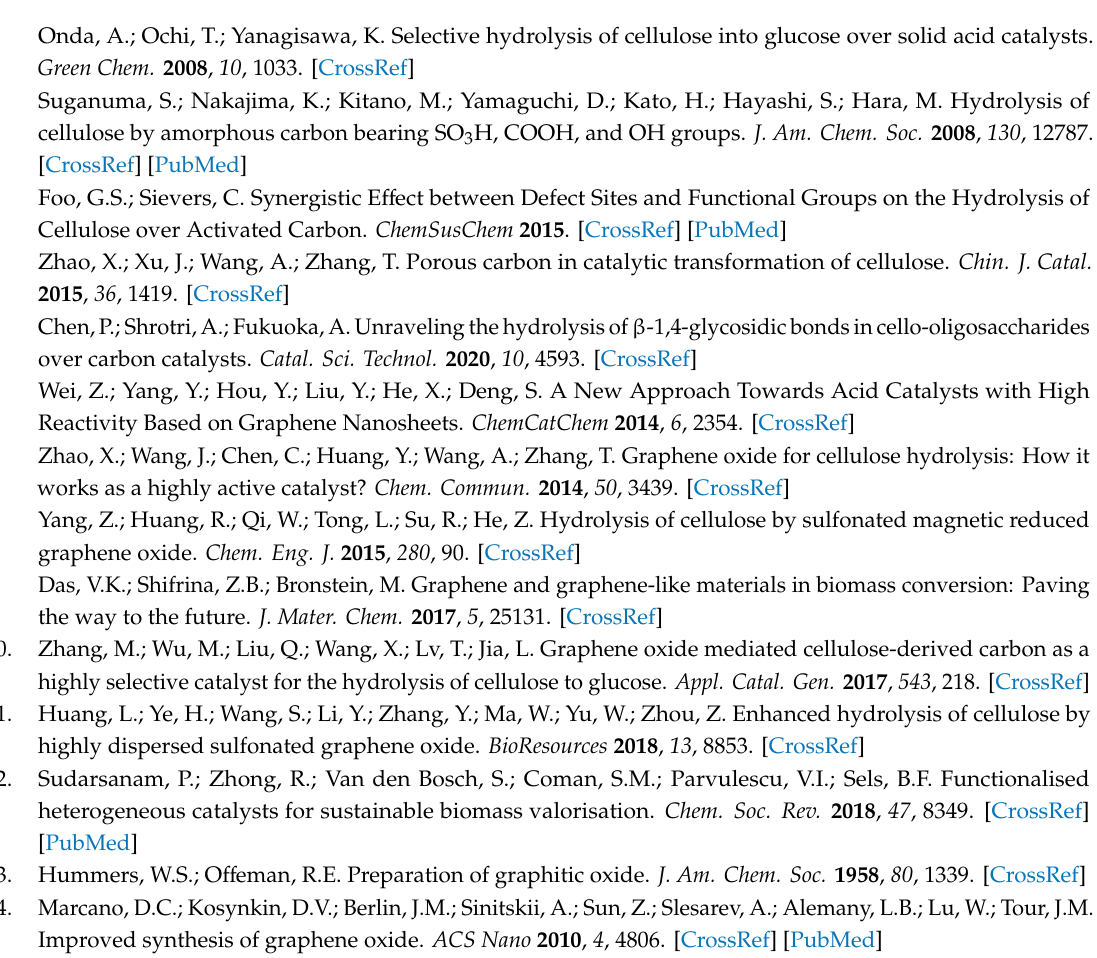
Figure S1: XRD patterns of (a) the exfoliated graphite precursor, (b) GO; Figure S2: Raman spectra of (a) exfoliated graphite precursor (b) GO; Figure S3: Kinetic of celllulose hydrolysis in liquid products catalyzed by Cs 2 HPW 12 O 40 . Reaction conditions: T = 190 ◦ C, p~11at, m catalyst = 0.68 g, m cellulose = 1.6 g, m water = 65 g, Ar Atm; Figure S4: Kinetic of celllulose hydrolysis in liquid products in the absence of catalyst. Reaction conditions: T = 190 ◦ C, p~11at, m cellulose = 1.6 g, m water = 65 g, Ar